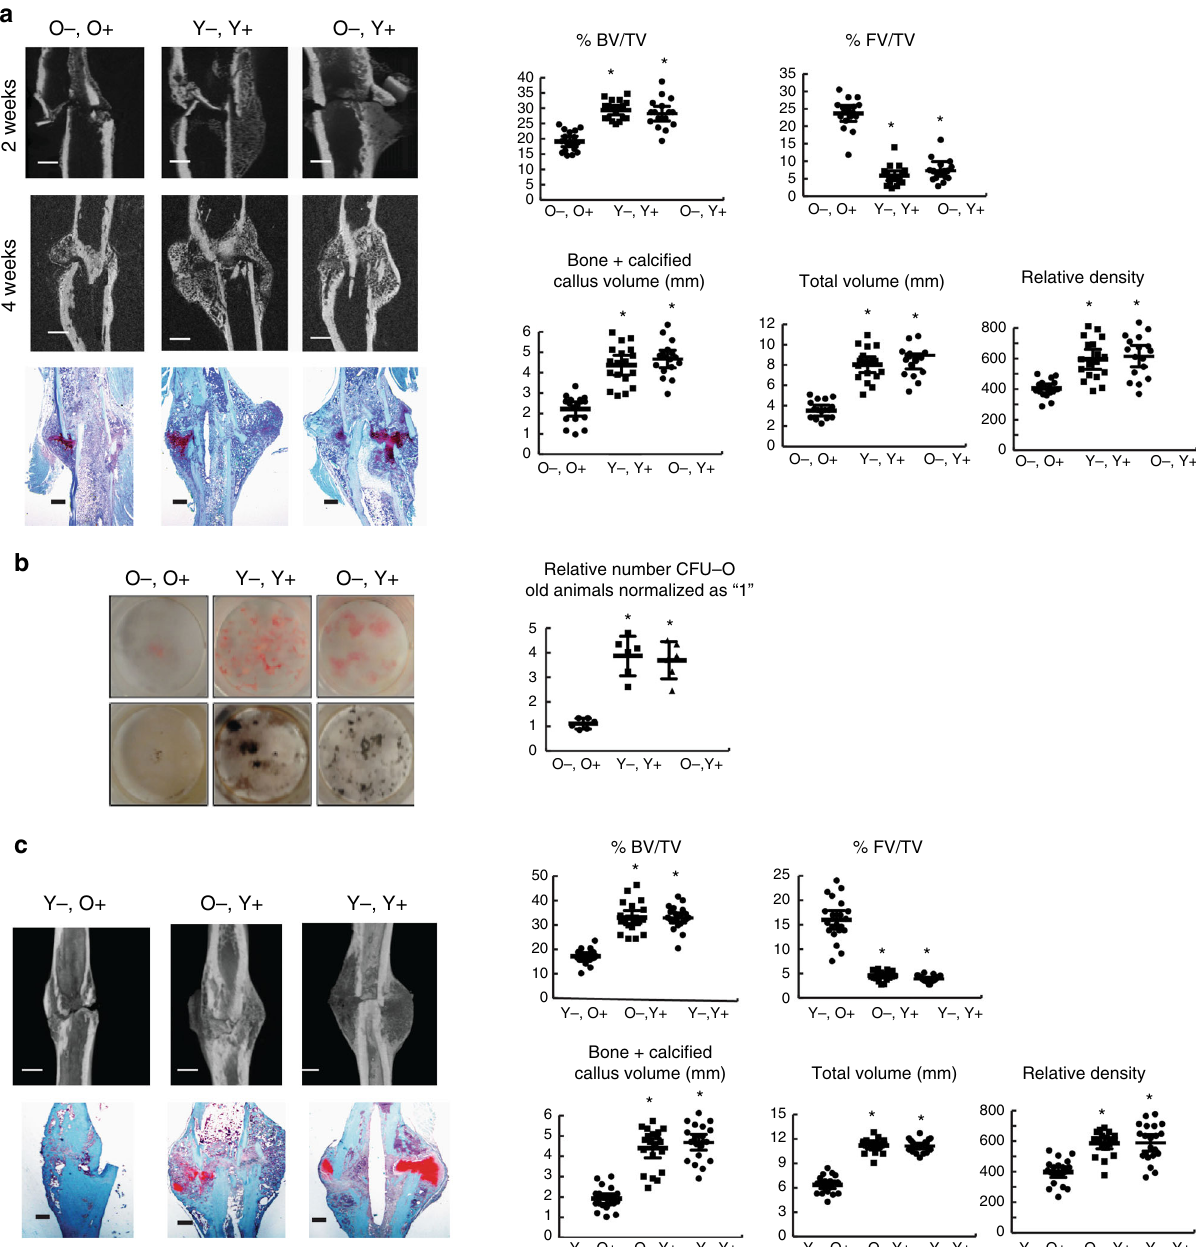
Fig. 2 F4/80-positive cells from young animals enhance fracture repair and osteogenic differentiation. a Young (Y) and old (O) bone marrow cells were sorted into F4/80 high ( + ) and low ( − ) populations using fl ow cytometry and re-introduced into irradiated recipient old mice. Representative micro-CT radiographic images after a tibia fracture and Safranin O stained histologic images from the tibia of an old mouse 4 weeks after the bone was fractured in mice with transplanted with combinations of F4/80 high or low fractions from bone marrow from old or young donor mice. Graphs show bone volume/ total volume (BV/TV) in %; total fi brous tissue/total volume (FV/TV) in %; bone plus calci fi ed callus volume (mm 3 ) or total callous volume (mm 3 ), or relative density from tibias 4 weeks after fracture. Each data point is shown, along with means and 95% con fi dence intervals for each experimental group. n = 8 males, 9 females O − ,O + , n = 9 males, 9 females for Y − ,Y + , n = 9 males, 8 females for O − ,Y + . b CFU-O from mice in A, with numbers that form from bone marrow cells from old mice. Representative cell culture plates (Von Kossa and Alk Phosphate staining shown) and each data point as well as means and 95% con fi dence intervals for each group with the mean from control culture de fi ned as “ 1 ” (right). c Young (Y) and old (O) bone marrow cells sorted into F4/80 high ( + ) and low ( − ) populations using fl ow cytometry were re-introduced into irradiated recipient young mice ( n = 6 in each group). Representative radiographic images 2 and 4 weeks after the fracture, and histologic images from the tibia of old mice 4 weeks after the bone was fractured transplanted with various combinations of F4/80 high or low bone marrow fractions. Graphs show each data point for bone volume/total volume (BV/TV) in %; total fi brous tissue/total volume (FV/TV) in %; bone plus calci fi ed callus volume (mm 3 ), total callous volume (mm 3 ), or relative density. Data are shown as means and 95% con fi dence intervals. n = 11 males, 10 females for Y − ;O + , n = 10 males, 10 females for O − :Y + , n = 10 males, 11 females for Y − ; Y + . An asterisk over a data point shows a signi fi cance p < 0.05 compared to controls, comparison using